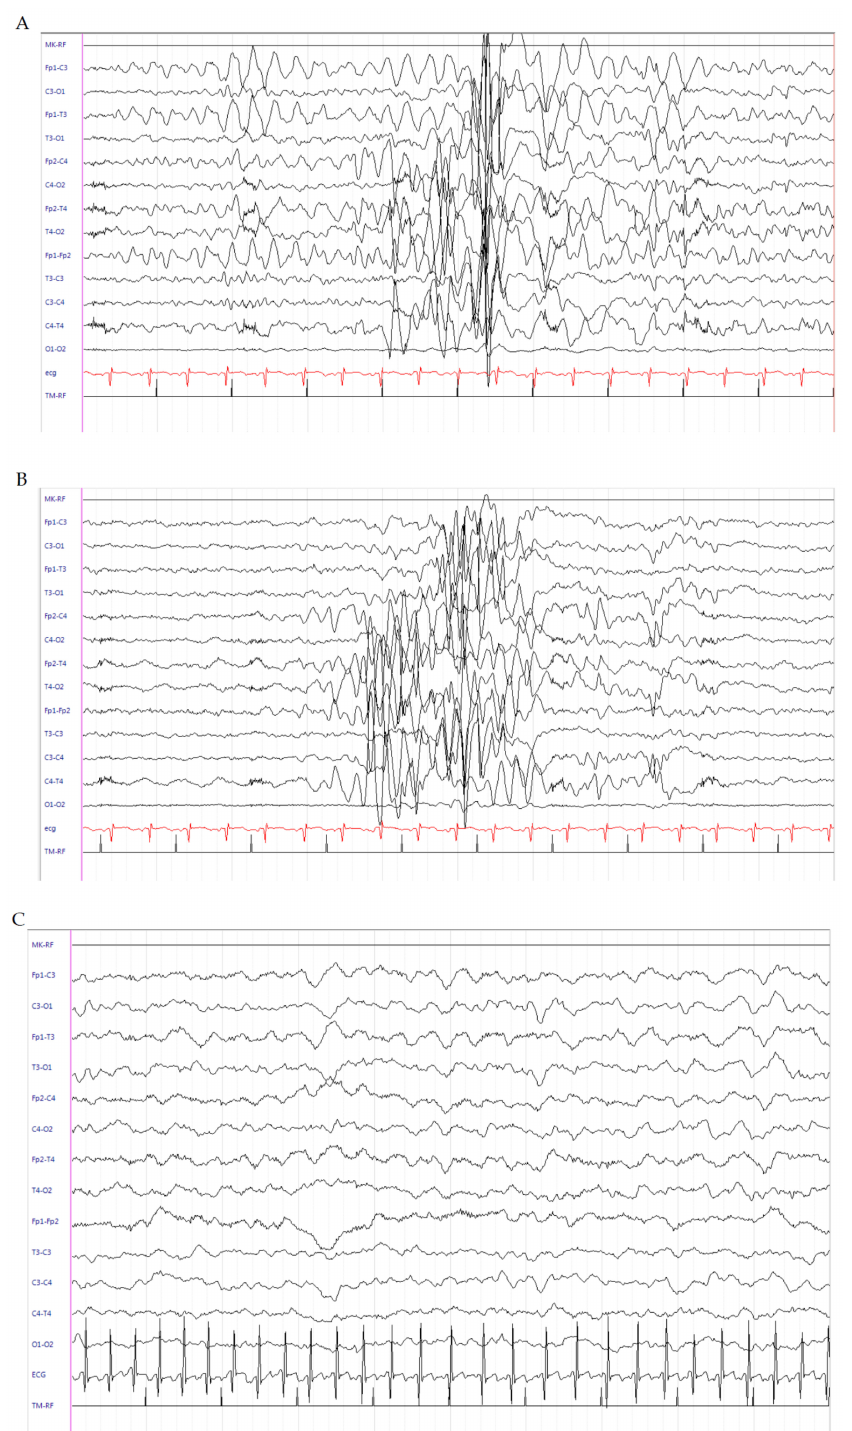
Figure 1. Electroencephalogram (EEG) of patient 1. ( A ) Interictal pattern characterized by onset of high-voltage delta waves in left frontal regions, suddenly spreading to the counter-lateral homologous regions, and ( B ) subsequent generalization, followed by medium–high-voltage delta waves in bilateral centrotemporal regions. ( C ) Background activity mainly characterized by medium–low-voltage theta